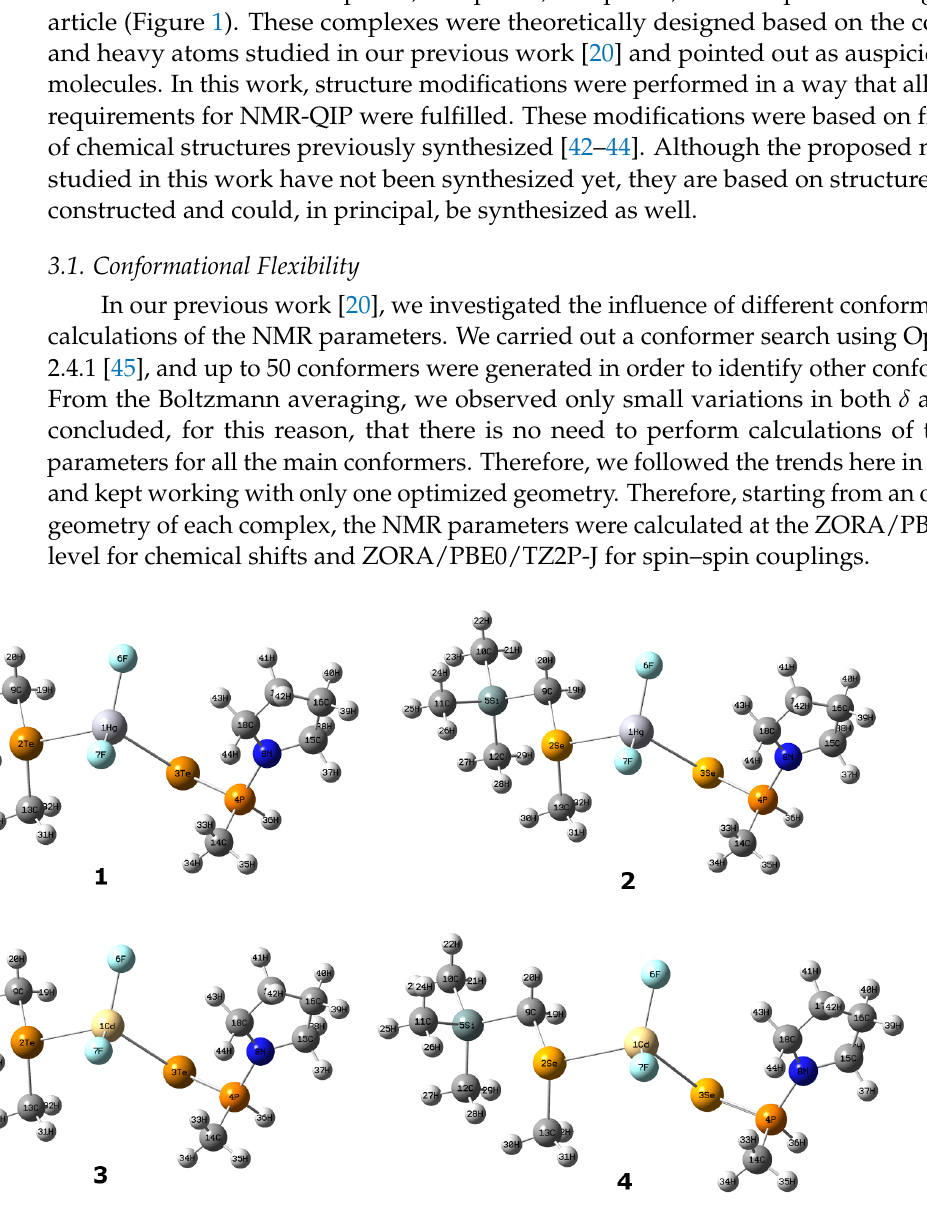
Figure 1. Studied complexes HgF2[((CH3)3SiCH2)(CH3)Te][(C4H8N)(CH3)HPTe] (com- plex 1), HgF2[((CH3)3SiCH2)(CH3)Se][(C4H8N)(CH3)HPSe] (complex 2), CdF2[((CH3)3SiCH2) (CH3)Te][(C4H8N)(CH3)HPTe] (complex 3), and CdF2[((CH3)3SiCH2)(CH3)Se][(C4H8N)(CH3)HPSe] (complex